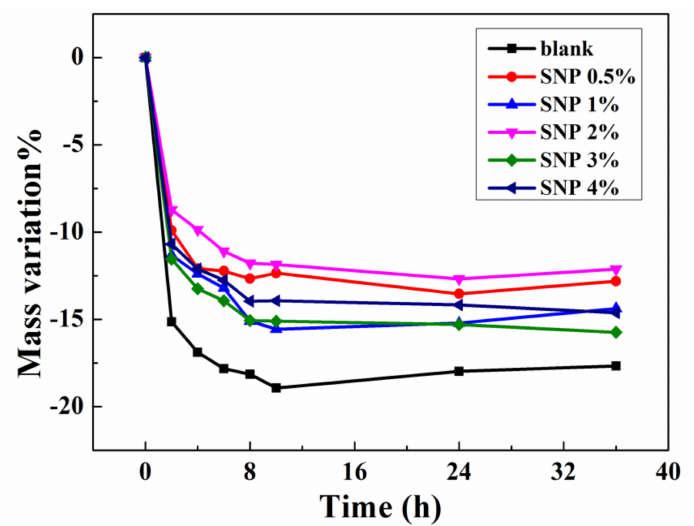
Figure 4. Thermal stability of ionogel samples with di ff erent contents of